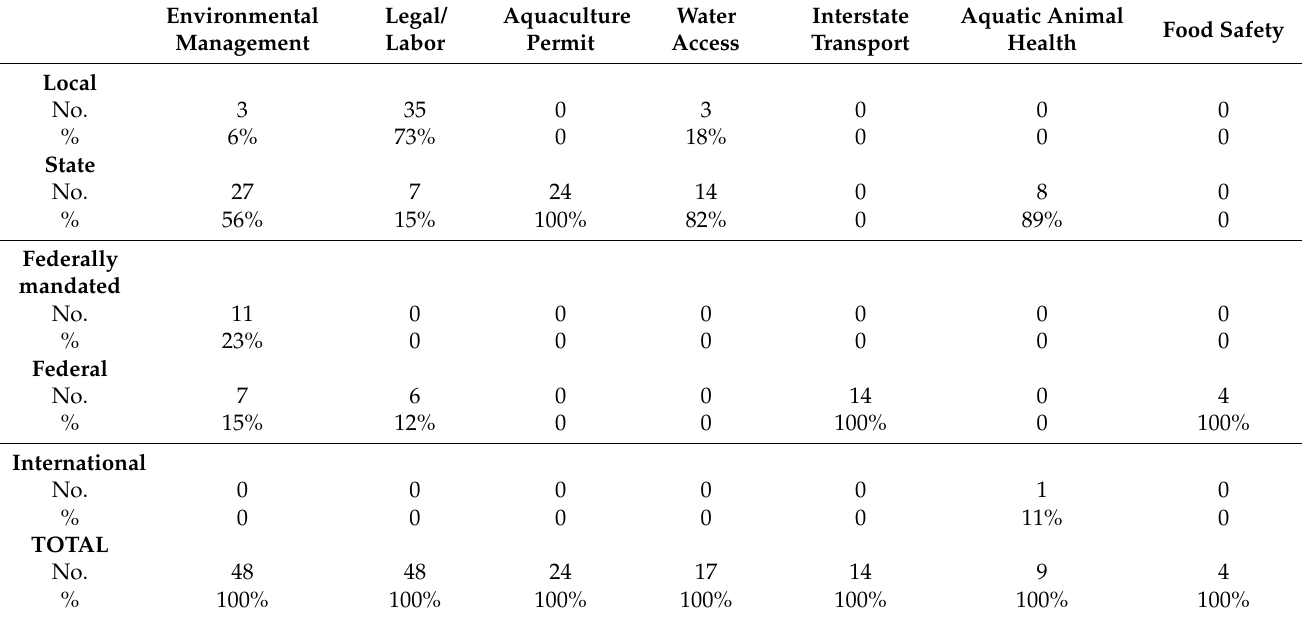
Table 6. Total number of permits/filings by six regulatory categories and level of government responsible. Percentage values calculated by